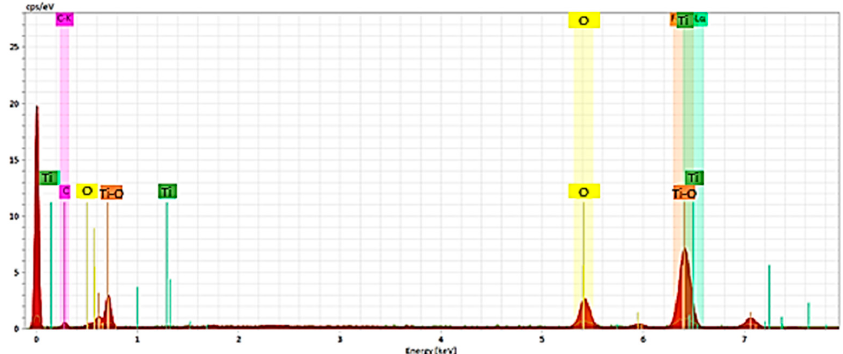
Figure 15. EDS ‐ SEM analysis composition of the non ‐ used tappers . Figure 15. EDS-SEM analysis composition of the non-used